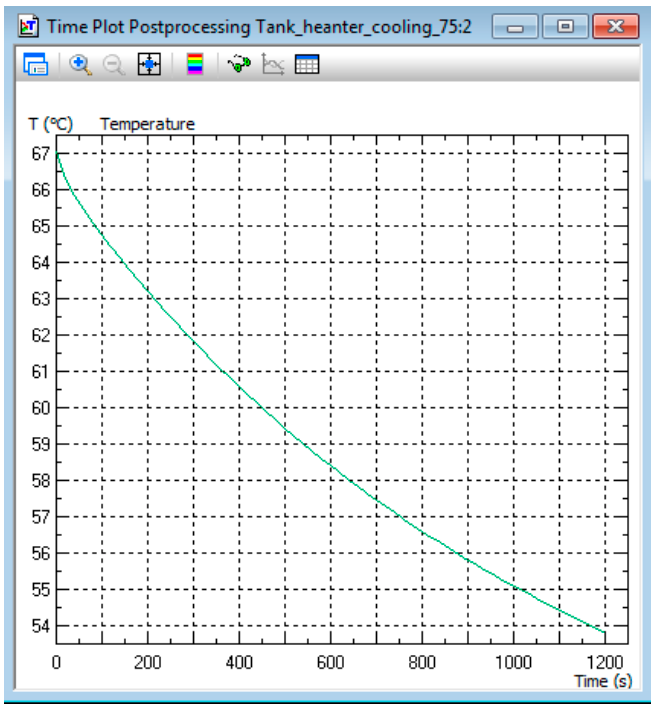
Figure 12. The temperature changes of the AMD ferrite ring during the cooling process for 1200